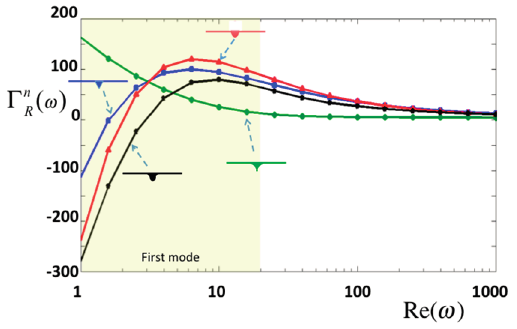
Figure 8. Normalized hydrodynamic force in real part per unit length for normal